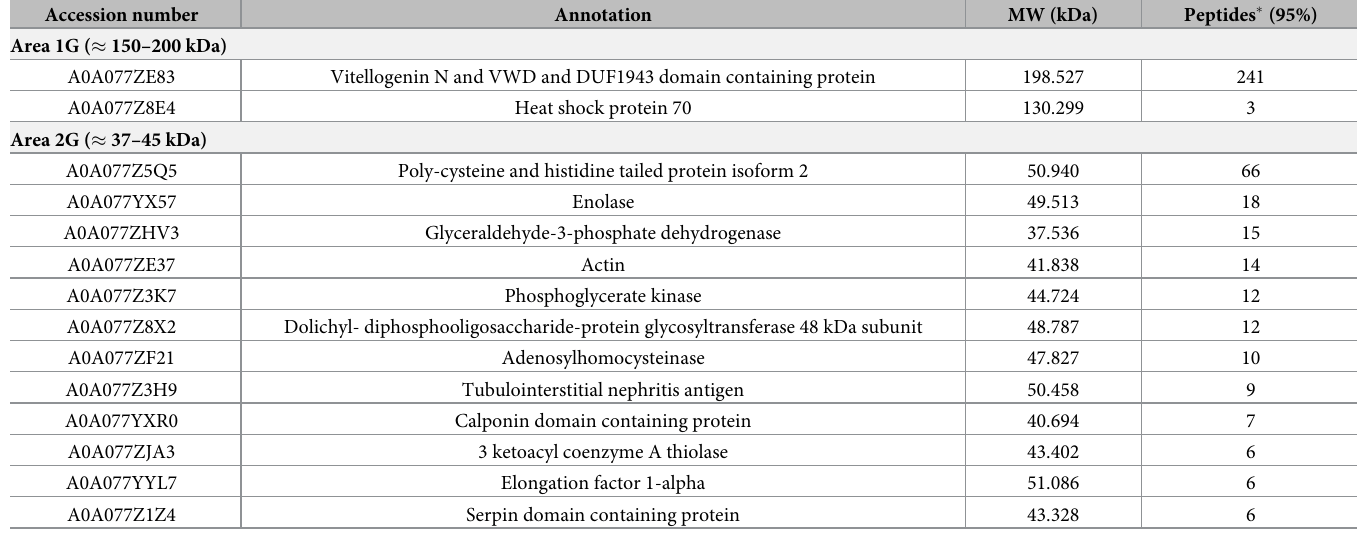
Table 3. Protein identities, in decreasing abundance, in immunodominant bands 1W and 2W in Western blots with EE as antigen. Proteins were identified by LC-MS/MS of corresponding areas in SDS-PAGE gels, 1G and 2G.